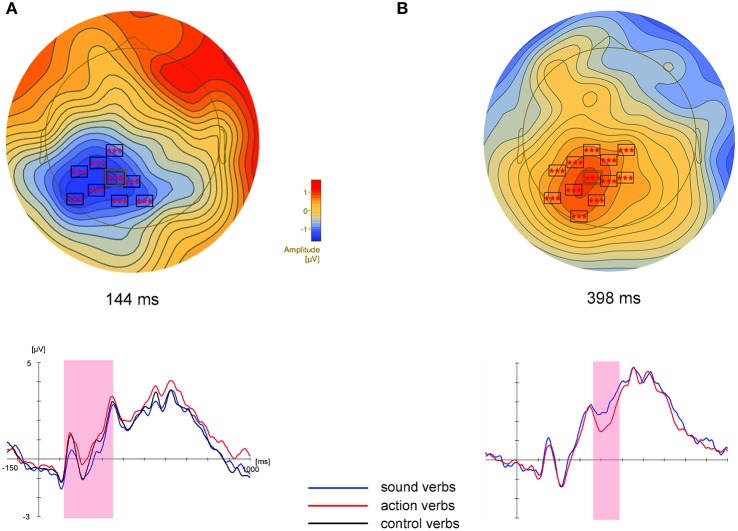
Results of the cluster permutation tests for the sound vs. action feature comparison. Above: Topographic map of the large centro-parietal cluster at the time point of the highest F-value across all electrodes of this cluster (electrode P1, highlighted in the map). Shown are only electrodes of this cluster with significant F-values (p < 0.05) at the depicted time point. For all electrodes within clusters and all clusters, we refer to Tables 2, 3. Cluster electrodes are overlaid on interpolated potential differences between sound and action conditions. Below: Grand-averaged ERPs for peak electrode P1 of these clusters. Colored shadings indicate the significant time window of the corresponding cluster. (A): Experiment 1, (B): Experiment 2.